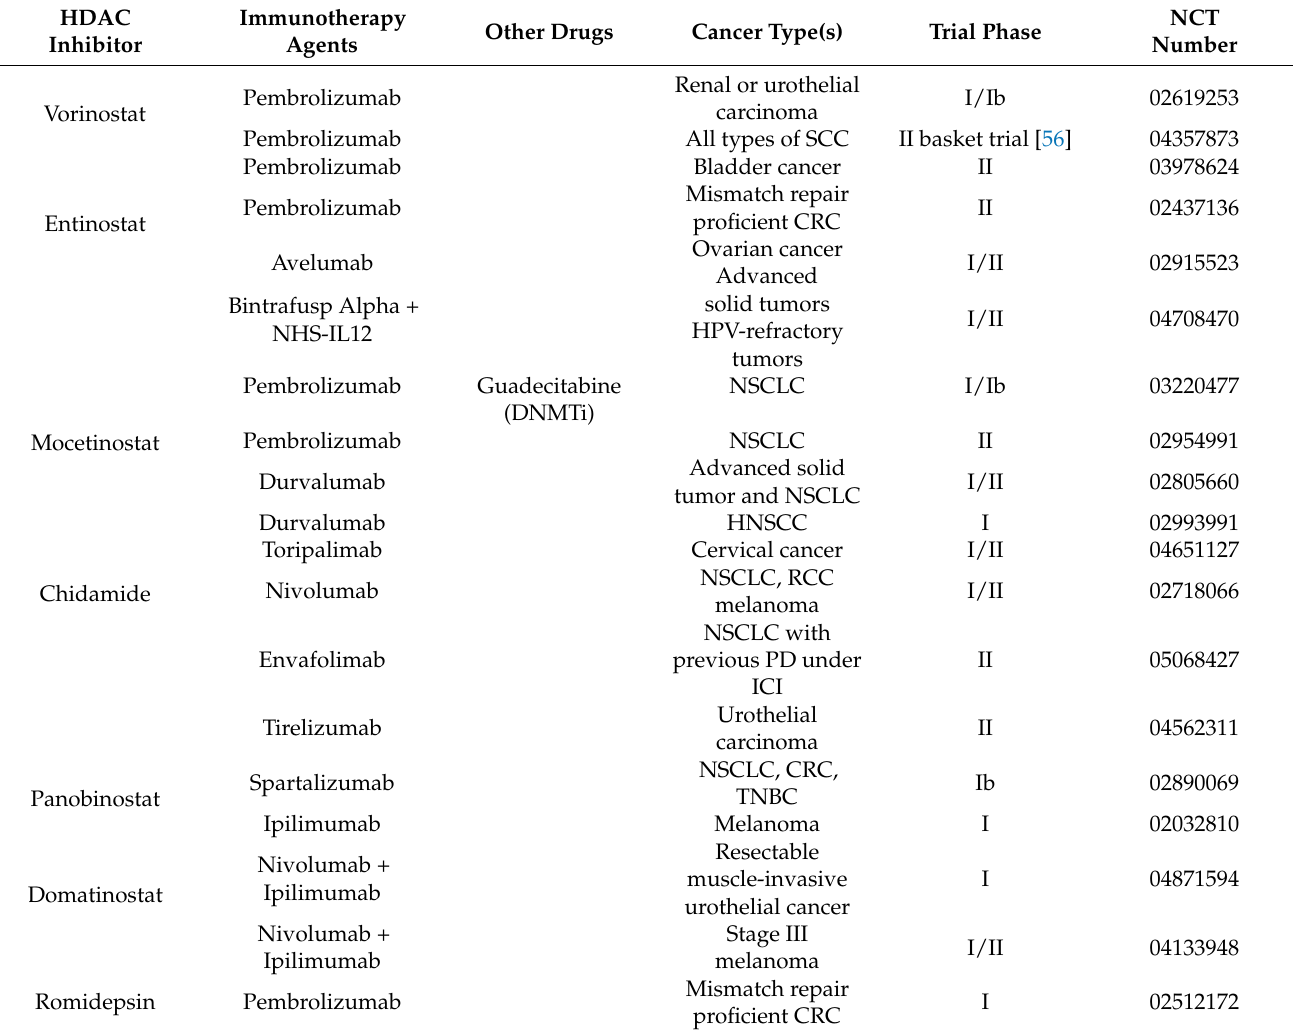
Table 2. Overview of ongoing clinical trials evaluating the combinations of HDAC inhibitors with immune checkpoint inhibitors in advanced solid